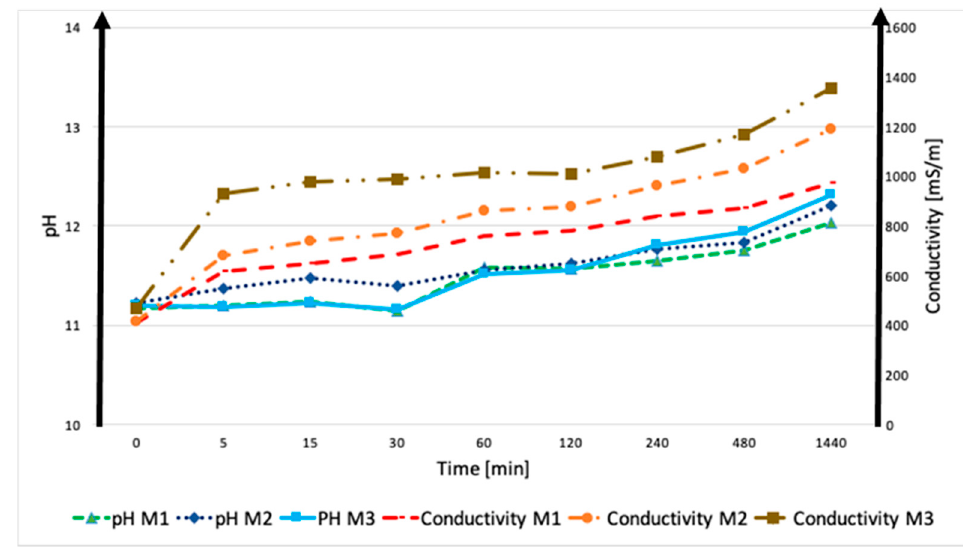
Figure 10. pH and conductivity of the following alkali-activated composites: M1, M2, M3. The error associated to these measurements is approx. 2% for pH and 8% for conductivity caused by sample variability. Table 6. Heavy metals (mg)L) in the AACs M1, M2, M3 eluates after the leaching test in acetic acid solution 0.5 N and in HCl solution 1:20 (the error associated with the measure is